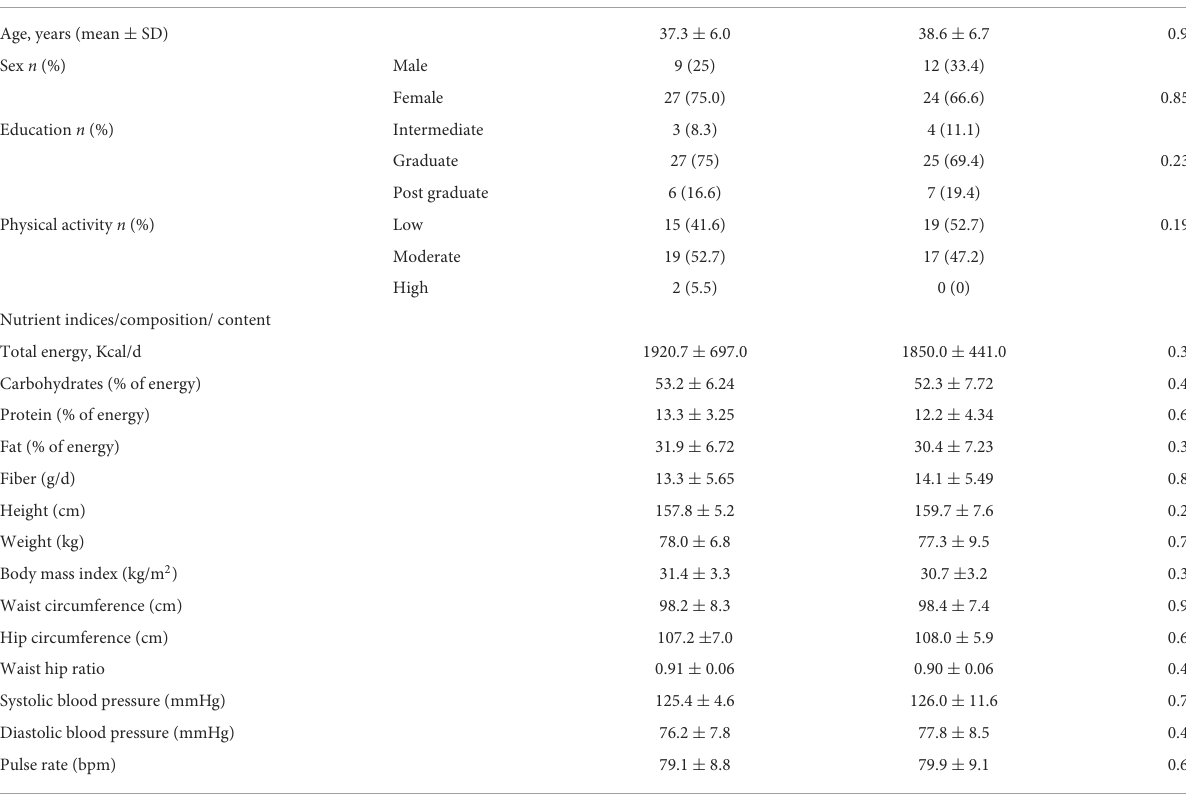
TABLE 1 Comparison of baseline characteristics of study participants. Demographic and physiological